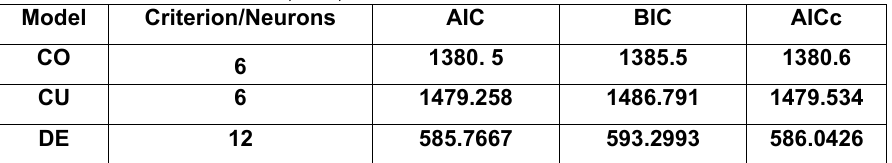
Table.7 AIC, BIC, and AICc Metrics for COCUDE model